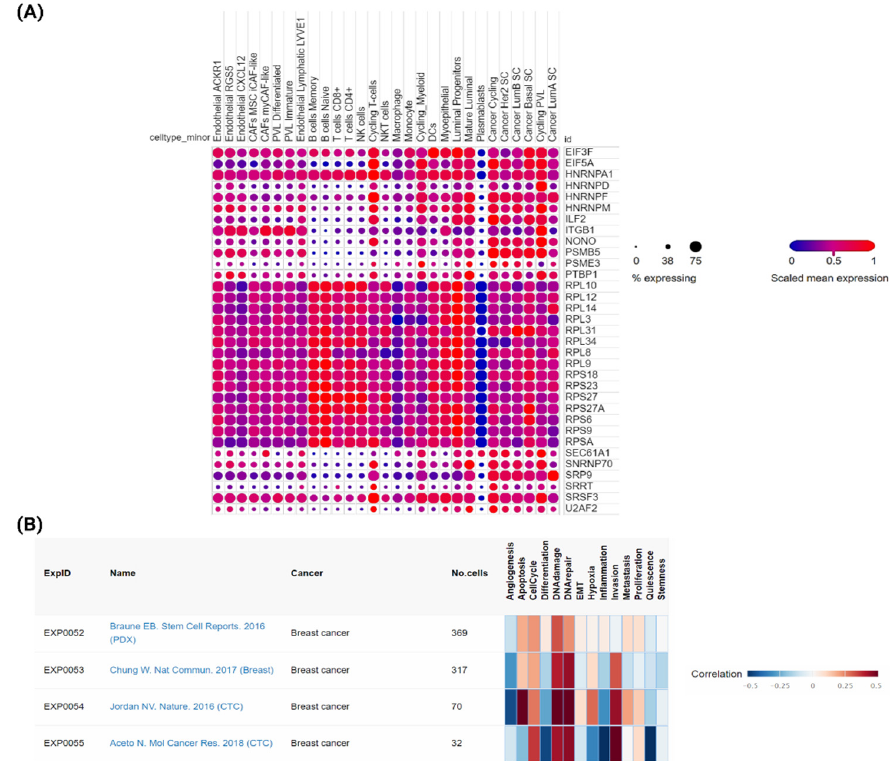
Figure 5. ( A ) Expression of hub genes in different cell types of scRNA-seq data of breast cancer patients from the study of Wu, S. et al. [47]. ( B ) The correlation heatmap shows the detailed infor- mation of all functional associations with hub genes in each breast cancer dataset available in Can- cerSEA